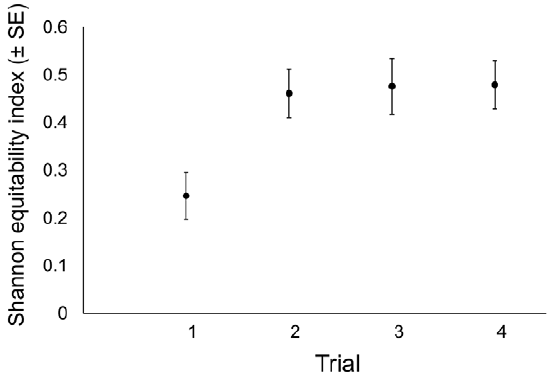
Figure 8. Egg dispersion by females inside enclosure. Mean values ( 6 SE) of the Shannon equitability index for each semi-field trial. This index takes into account both the number of eggs laid and their relative distribution among containers. This index reaches the maximum value (1) when eggs are evenly distributed among all containers and the minimum value (0) when eggs are concentrated within a single container.